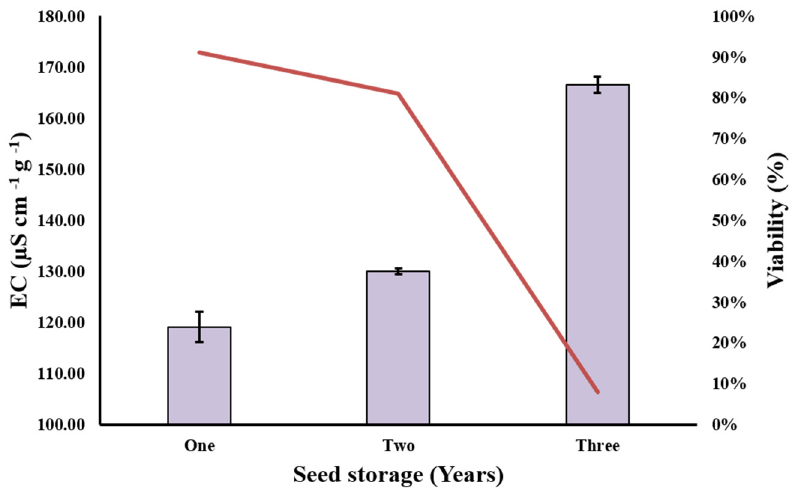
Figure 1. Effect of storage period on viability of seeds of G. superba using electrical conductivity (EC) test. The red line indicates the viability (%), while the bars indicate EC in µS cm − 1 g − 1 .